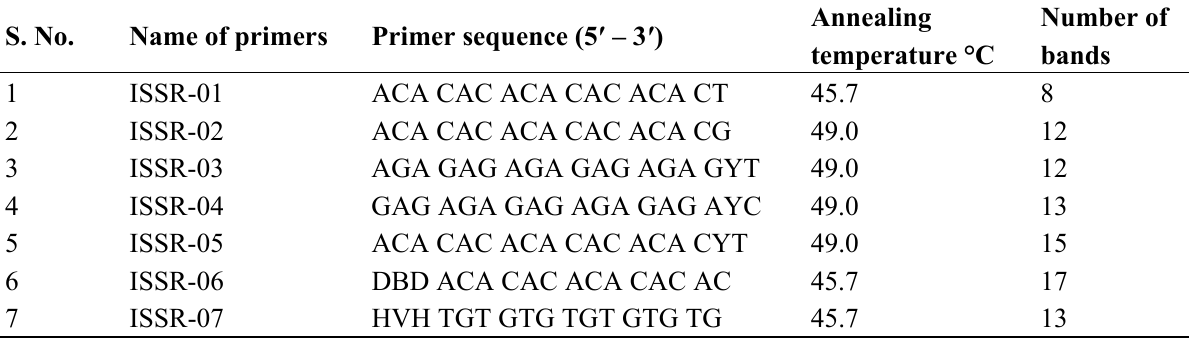
Table 4. List of ISSR primers used to verify the genetic fidelity of micropropagated plantlets of Rauvolfia serpentina a